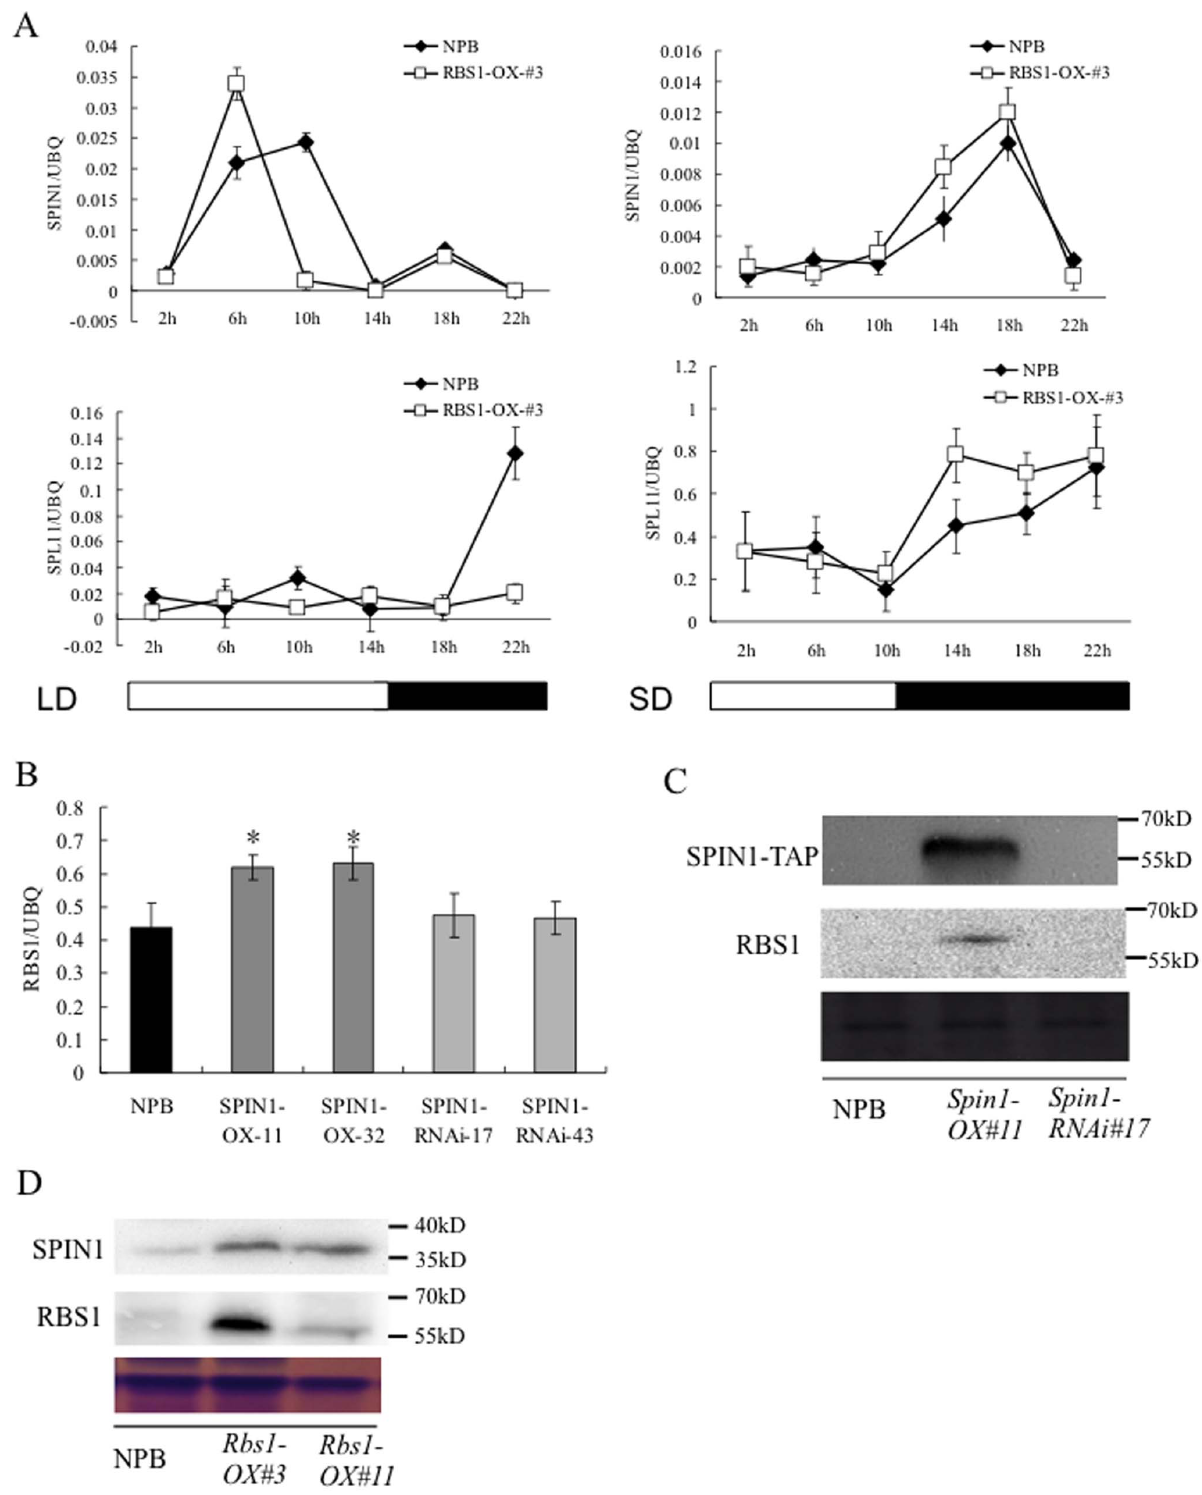
Figure 6. Gene expression and protein accumulation patterns of Rbs1,Spin1 and Spl11 inthe Rbs1andSpin1 overexpression plants. A. Q-PCR analysis of the expression pattern of Spin1 and Spl11 in the Rbs1 overexpression plants under LD and SD conditions. B. Expression of Rbs1 in the Spin1 overexpression and RNAi plants. C. Western blot detection of RBS1 and SPIN1 proteins in the Spin1 overexpression and RNAi plants. RBS1 was detected using a native antibody. The SPIN1-TAP fusion protein was detected in the Spin1 -OX plants using the PAP antibody. D. Western blot detection of RBS1 and SPIN1 proteins in the Rbs1 overexpression lines; RBS1 and SPIN1 native antibodies were used in the immunoblot detection.